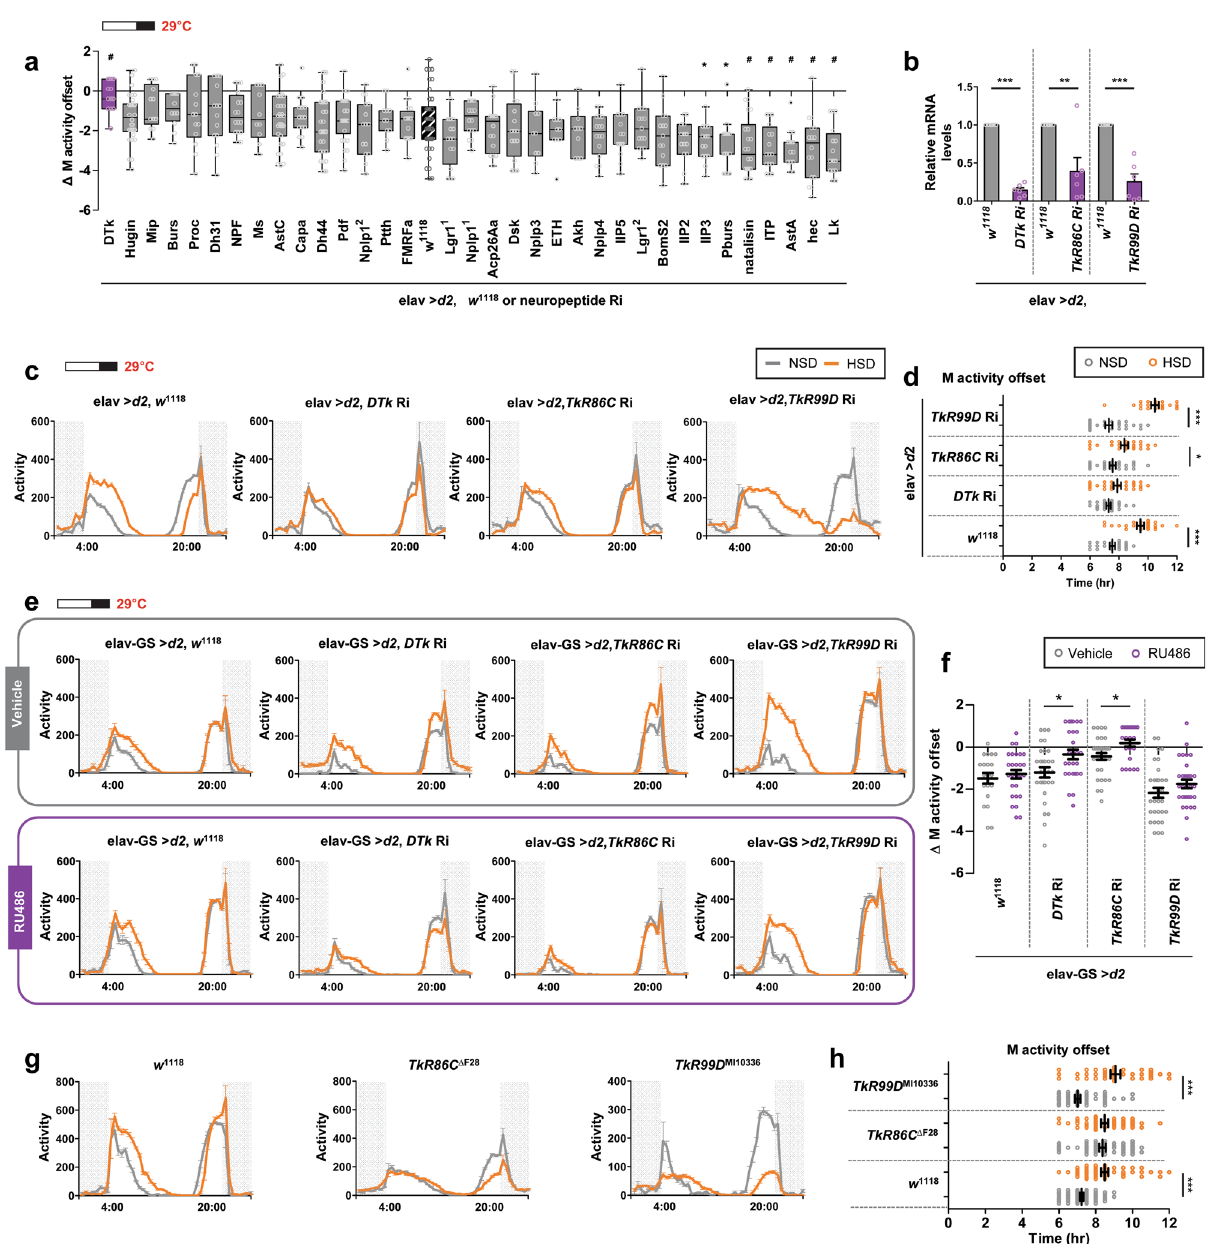
Fig. 3 Neuropeptide DTk and the DTk receptor TkR86C were required for M activity extension in HSD. a – d w 1118 fl ies or UAS-neuropeptide RNAi (denoted on bottom) fl ies were crossed with elav-Gal4, UAS- dcr2 (elav > d2 ). a The locomotor activities of offspring were analyzed in NSD or a HSD under a 16L:8D cycle at 29 °C. Differences in average M activity offset between NSD and HSD ( Δ M activity offset) on day 7 are shown. Control fl ies (hatched box;elav > d2 , w 1118 ) showed delayed M activity offset in HSD. The DTk knockdown fl ies (purple box; elav > d2 , DTk Ri) showed little difference with a NSD versus a HSD ( n = 9 – 16). Statistically signi fi cant differences in Δ M activity offset between the control and knockdown fl ies (independent t test): * P < 0.05, # P < 0.01. b Flies with the indicated genotypes fed a NSD on a 16L:8D cycle at 29 °C were collected at ZT2. DTk, TkR86C, and TkR99D mRNA levels were quanti fi ed by qRT-PCR. The mRNA levels in the knockdown fl ies were normalized to the control (elav > d2 , w 1118 ) fl ies. Values indicate mean ± SEM from six independent experiments. Statistically signi fi cant differences in mRNA levels between control and knockdown fl ies (independent t test): ** P < 0.01, *** P < 0.001. c – h The locomotor activities of each fl y genotype (denoted above each graph) were analyzed in NSD and HSD under a 16L:8D cycle at 29 °C. c , e , g Daily activity pro fi les of fl ies on day 7 are shown. d , h The M activity offsets of individual fl ies on day 7 are shown. Bars indicate mean ± SEM ( n = 21 – 62). Statistically signi fi cant differences in the average time between NSD and HSD (independent t test): * P < 0.05, *** P < 0.001. f Δ M activity offset on day 7 are shown. Statistically signi fi cant differences in Δ M activity offset between vehicle- and RU486-treated groups for each genotype of fl ies (independent t test): * P < antibodies were contiguous with DTk-labeled neurons but did not overlap (Fig. 4b).